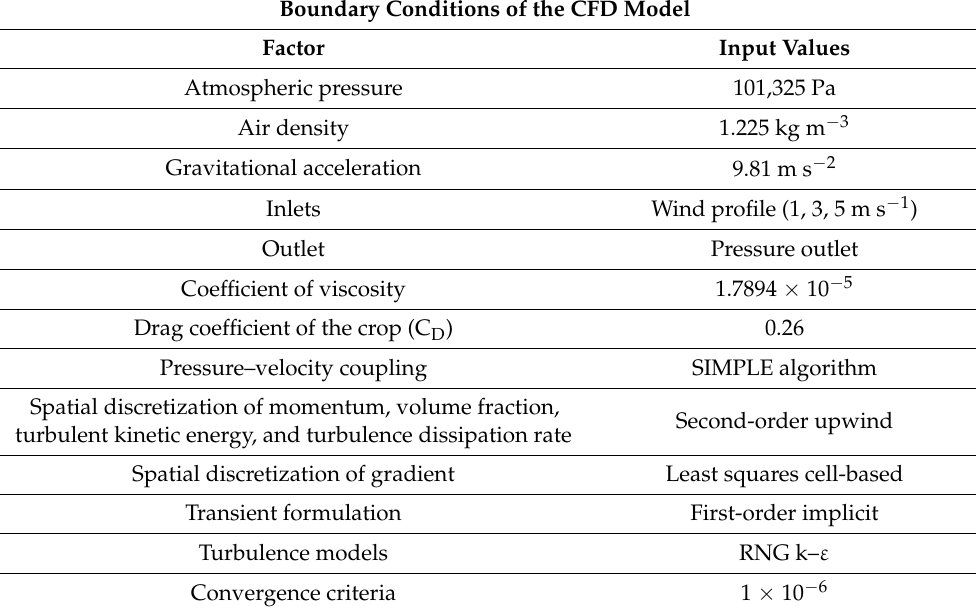
Table 4. Boundary conditions of the CFD model of evaluating the ventilation rate and C d of the